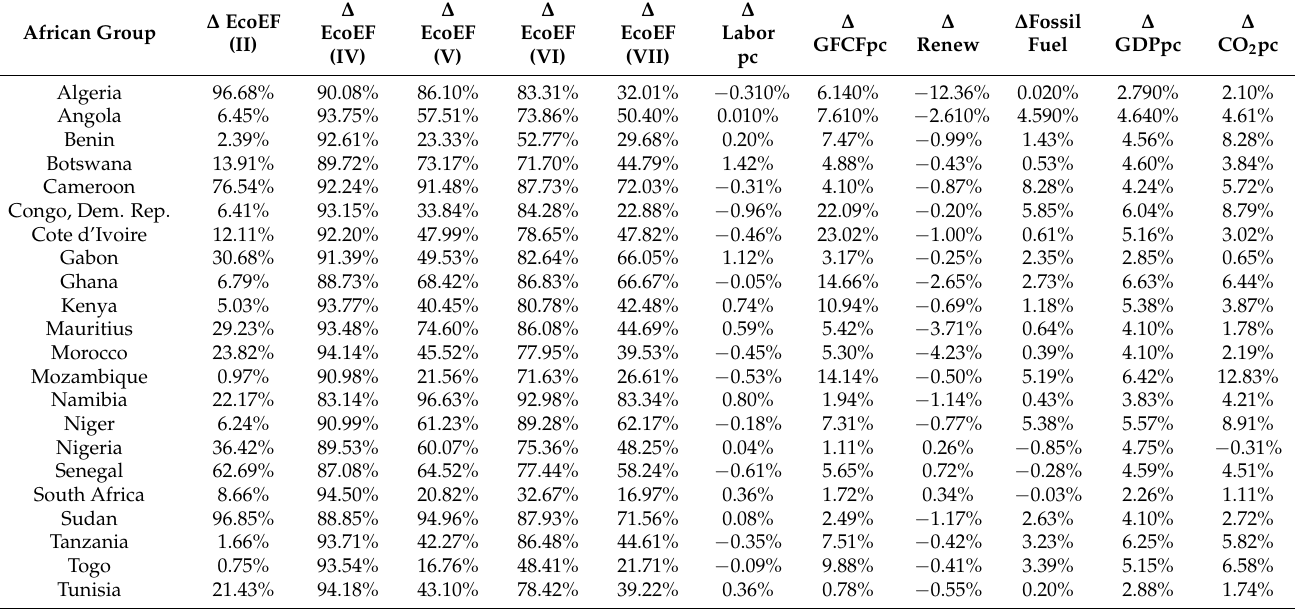
Table A2. Eco-Efficiency SFA scores for the 22 African economies and average growth rates by their drivers. African